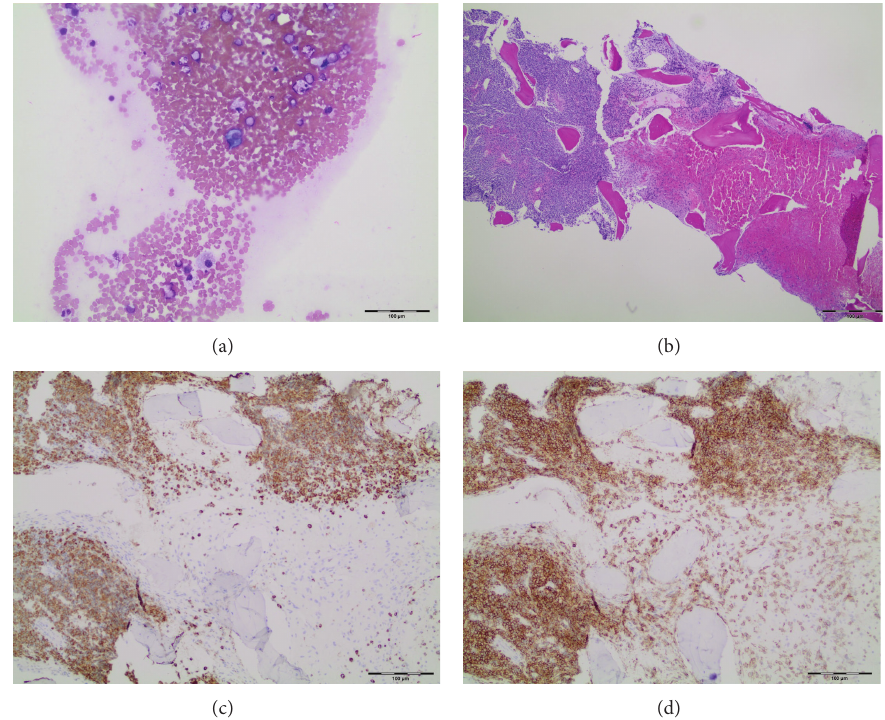
Figure 1: Initial core biopsy touch imprints. (a) Wright-Giemsa stained blood-dilute touch imprints; note the packed marrow on the left side. (b) Hemorrhagic necrosis on right side of this H&E stained section. (c) Immunoperoxidase staining of core biopsy for CD33; areas not taking the stain represent necrotic marrow. (d) Immunoperoxidase staining for Myeloperoxidase of a section from core biopsy.